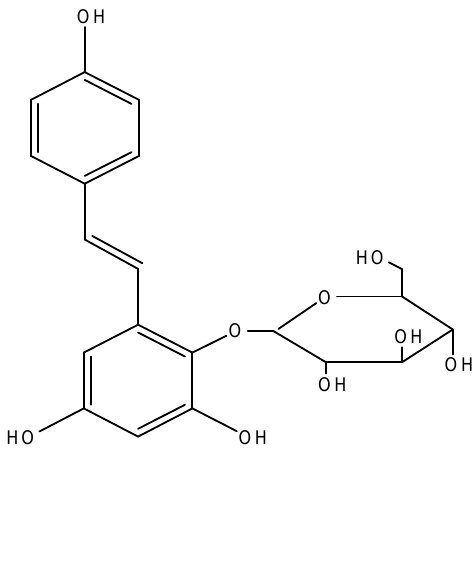
Figure 1. Chemical structure of stilbene